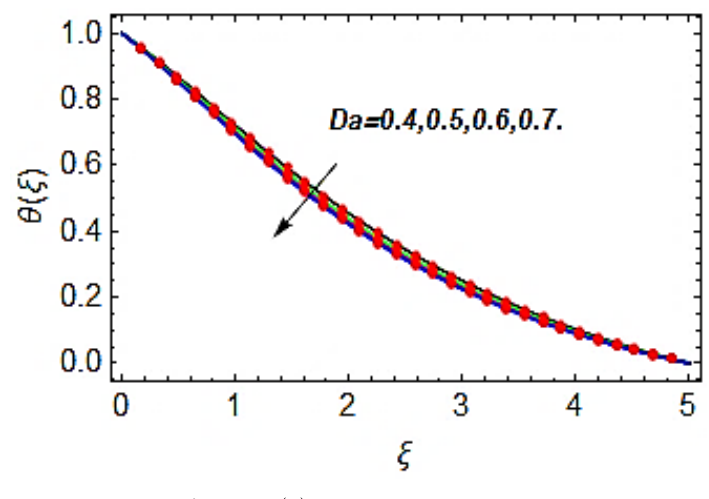
Figure 2. Impact of Da on θ ( ξ ) .